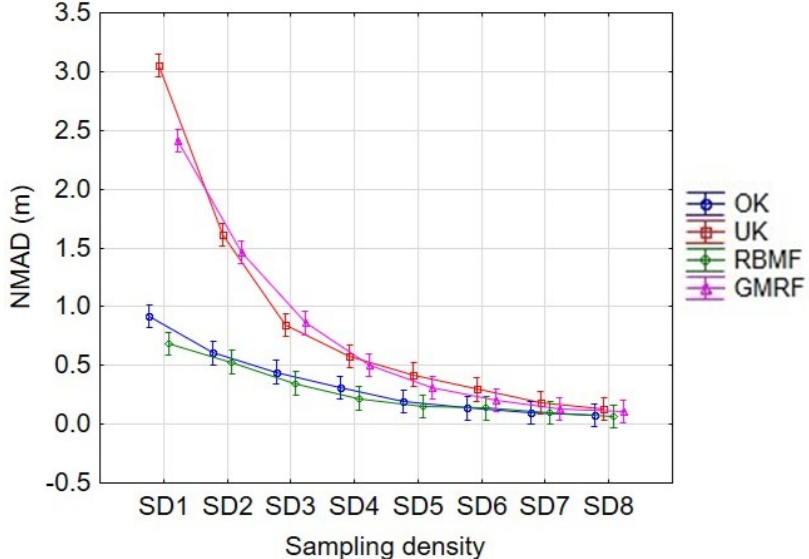
Figure 16. Plot of NMAD vs. Sampling Density factor for each interpolation method (interaction between SD and IM factors). Vertical bars denote 95% confidence intervals.